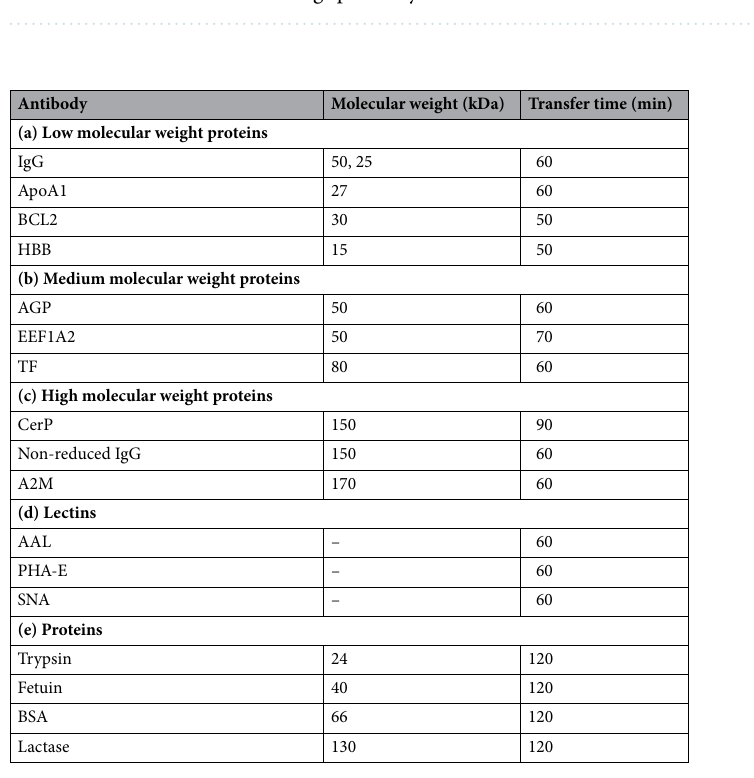
Table 1. Lectins and their binding specificity.